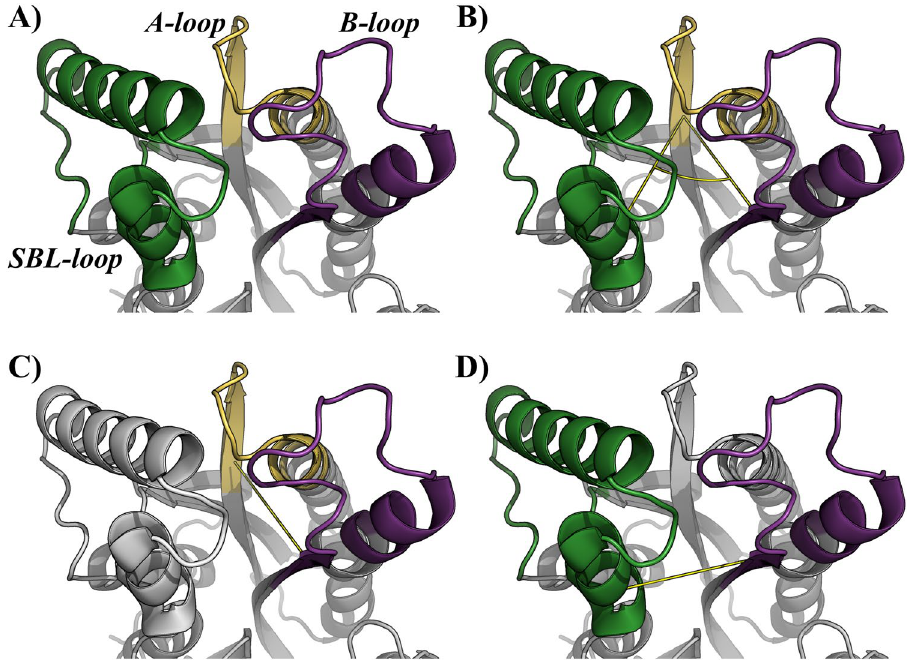
Figure 1. Definition of the structural analysis. The substrate binding cavity is defined by three motifs, the SB- loop (green), A-loop (purple) and B-loop (yellow). ( A) Description of the motifs involved in the analyses. ( B) Definition of the pincer angle and triangle area. ( C) A-loop and B-loop distance, and ( D) SB-loop and A-loop distance. The main chain of the enzyme is represented as cartoon . Image generated with PyMOL 36